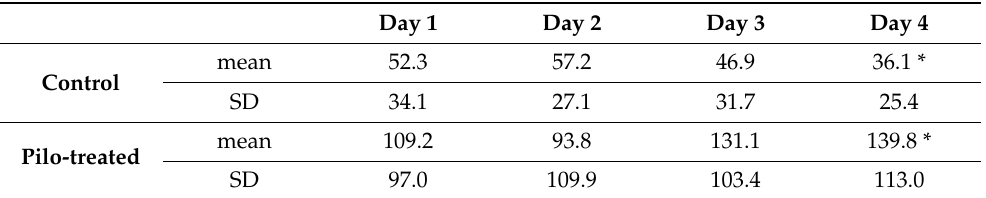
Table 2. The statistics of the latencies (in seconds) of finding the escape box in a Barnes maze on four consecutive days. Two trials were performed on each day, except day 4, which was the single probe trial. The statistical means of the latencies measured at the daily trials and the SDs are depicted. The number of animals was 9 in both groups. Using the Mann–Whitney test, the daily performances were tested statistically. A significant difference between the controls and PT animals was found only on day 4 ( p = 0.0295 *, * denotes significant difference).